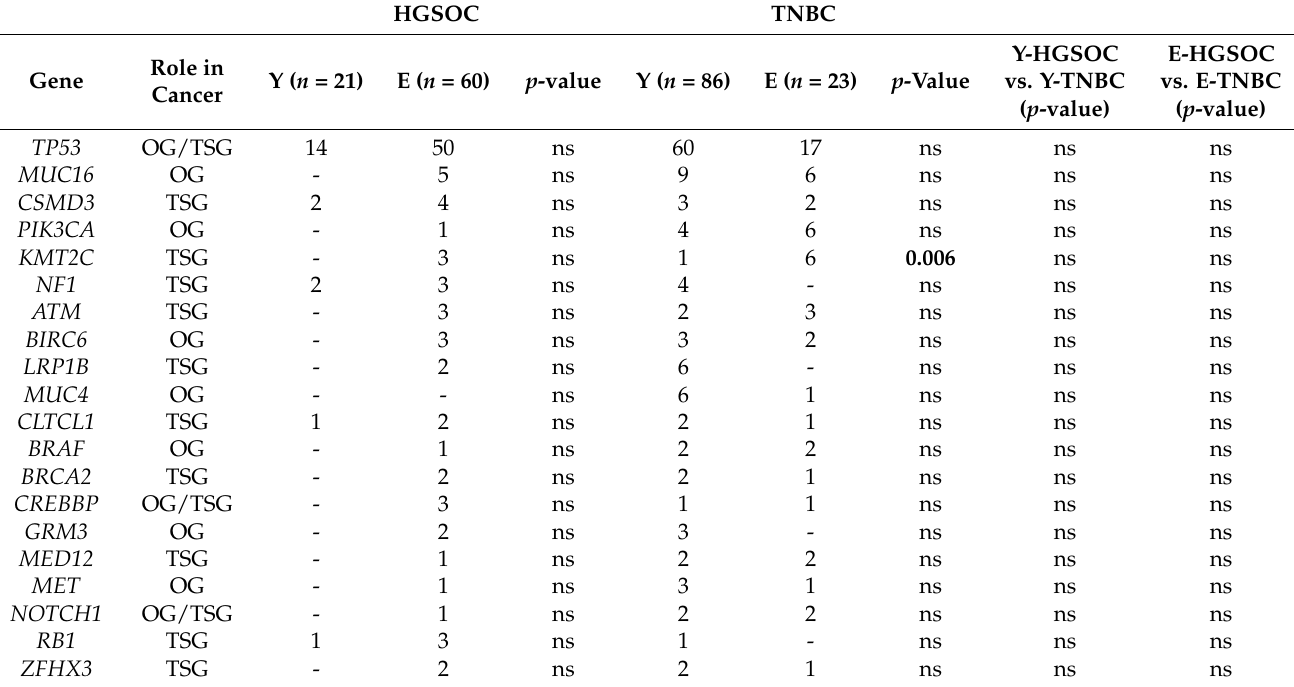
Table 2. Top 20 most commonly affected oncogenes (OG) and tumor suppressor genes (TSG) across HGSOC and TNBC (young -Y and elderly -Y). Bold: significant p